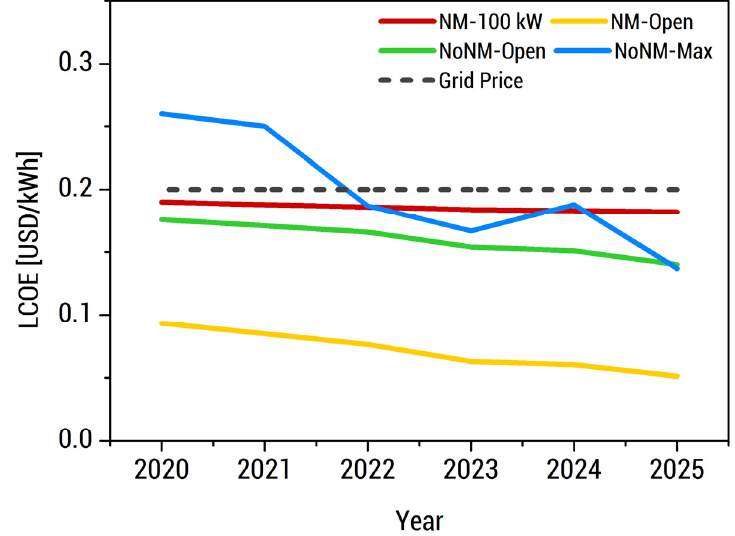
Figure 7. Calculated future LCOE of different grid-tied scenarios in comparison with the average annual cost of electricity from the grid within the analysis period of 2020 to 2025. The NoNM-Open scenario is the least-cost scenario allowed by current Philippine policies.